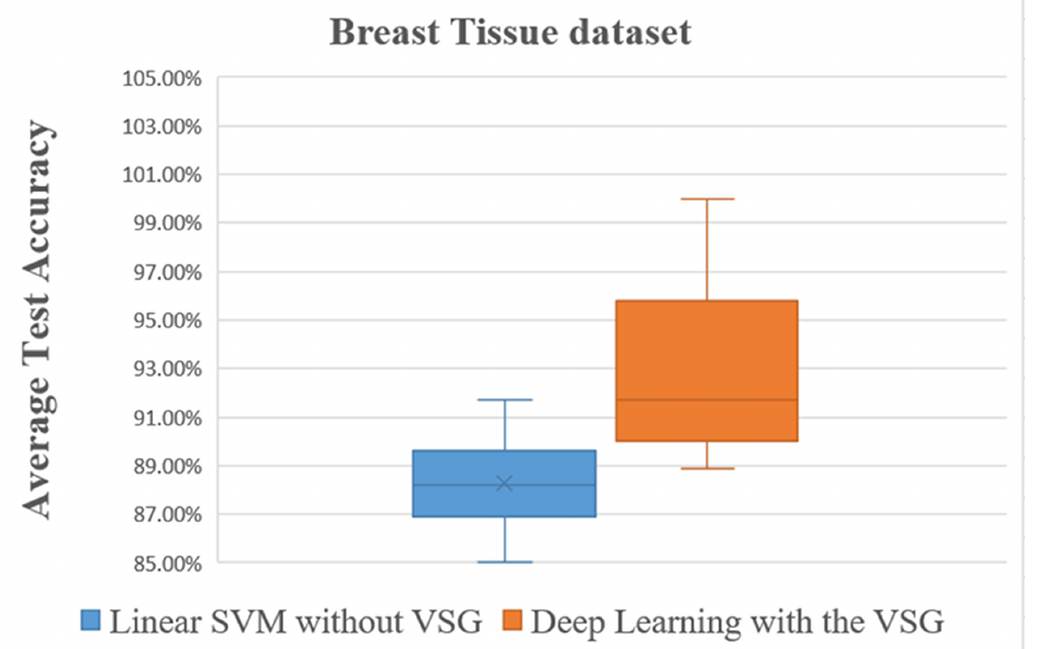
Figure 13. Overall comparisons of the experimental results using the Breast Tissue dataset.